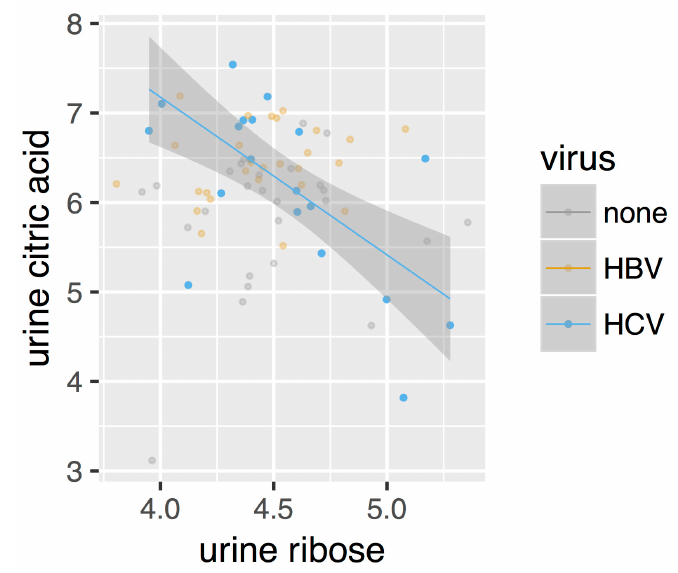
Figure 3. Scatterplot of the intensities of urine ribose and urine citric acid. Only the correlation in HCV (regression line and 95% confidence interval shown) is statistically significant.